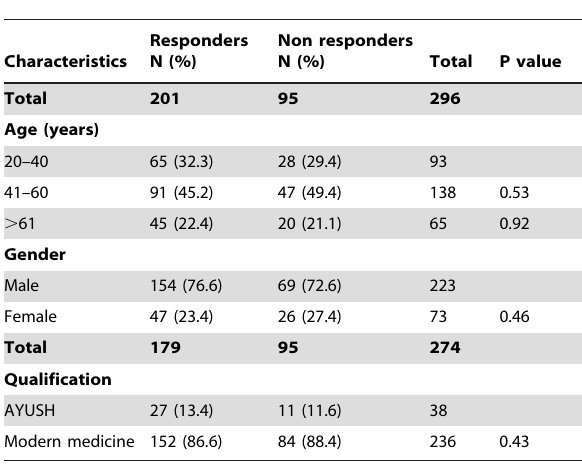
Table 1. Characteristics of responders and non-responders among private practitioners in Visakhapatnam, Andhra Pradesh.